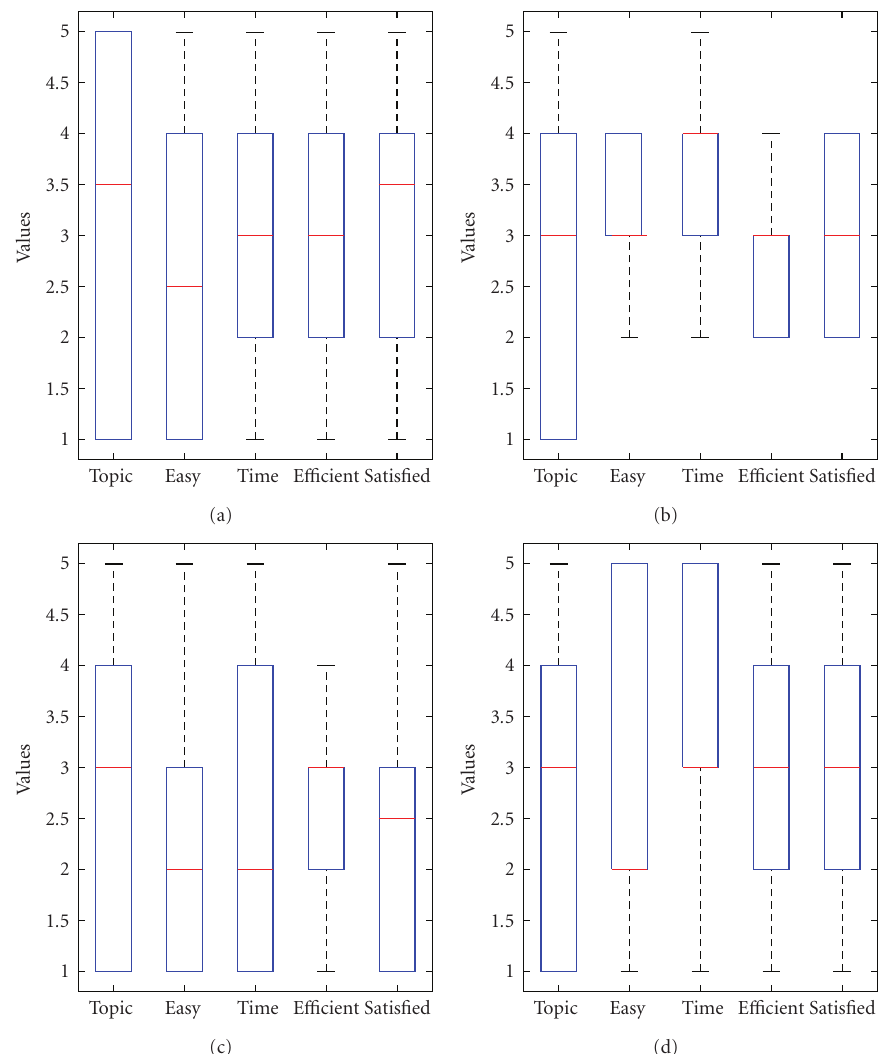
Figure 9: Results of the post-task question after each task done by the user using the Web-based version.